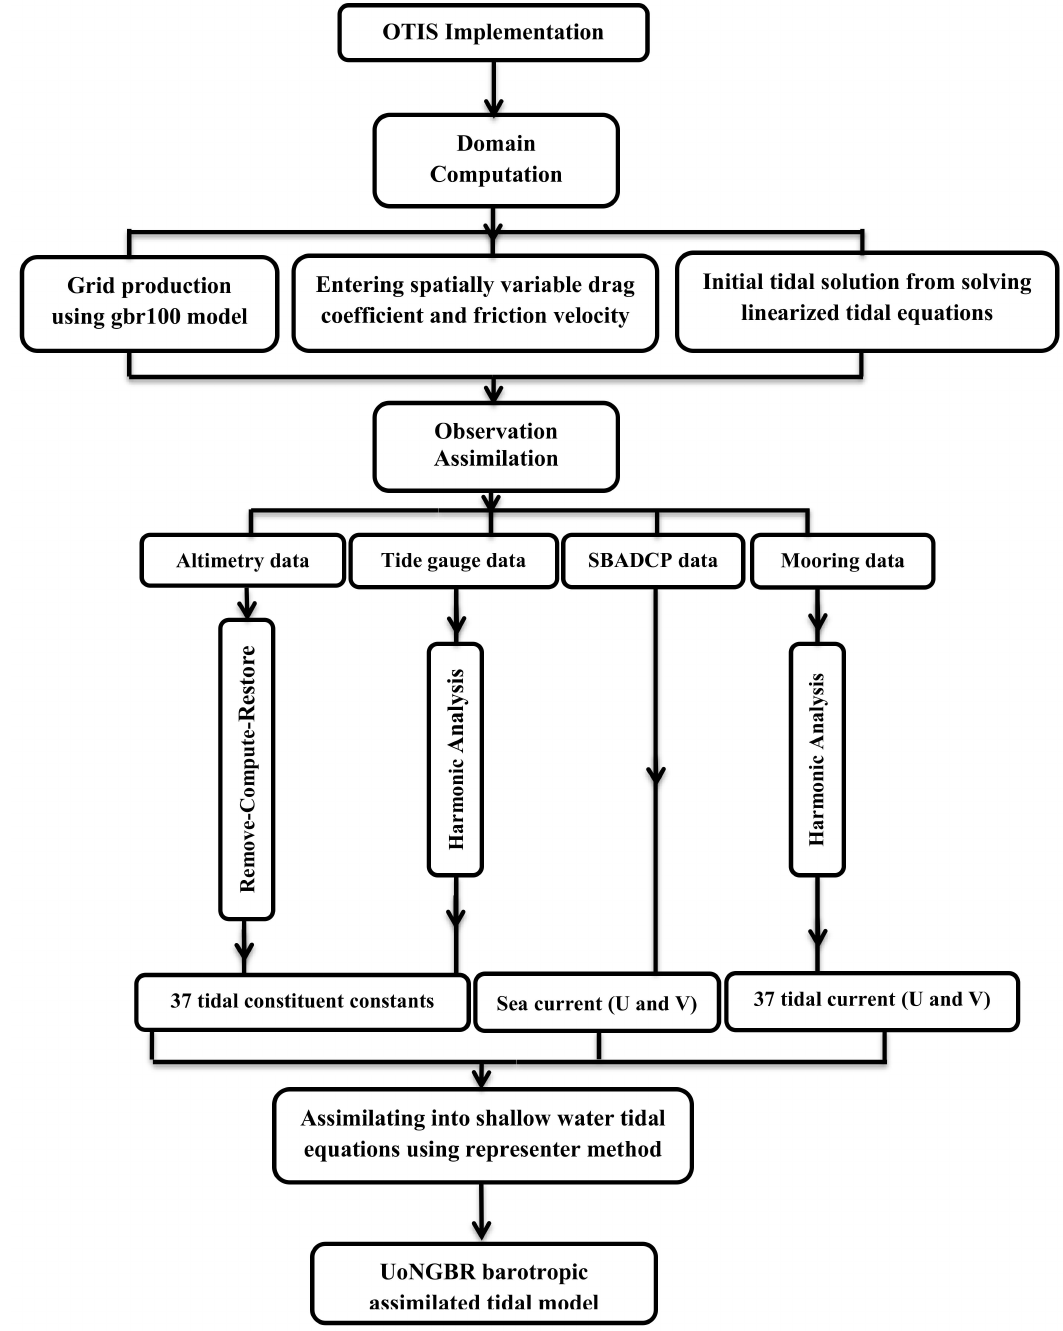
Figure 4. The flowchart demonstrating the implementation of the UoNGBR model with OTIS software. The U and V are tidal zonal and meridional current components,